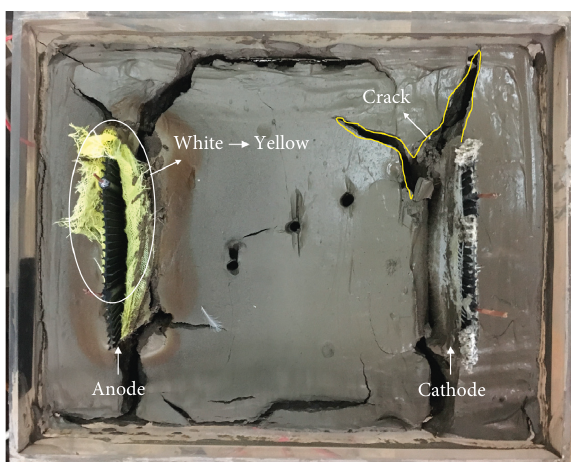
Figure 9: Changes in the phenomenological characteristics of the soil and electrodes after electroosmosis.